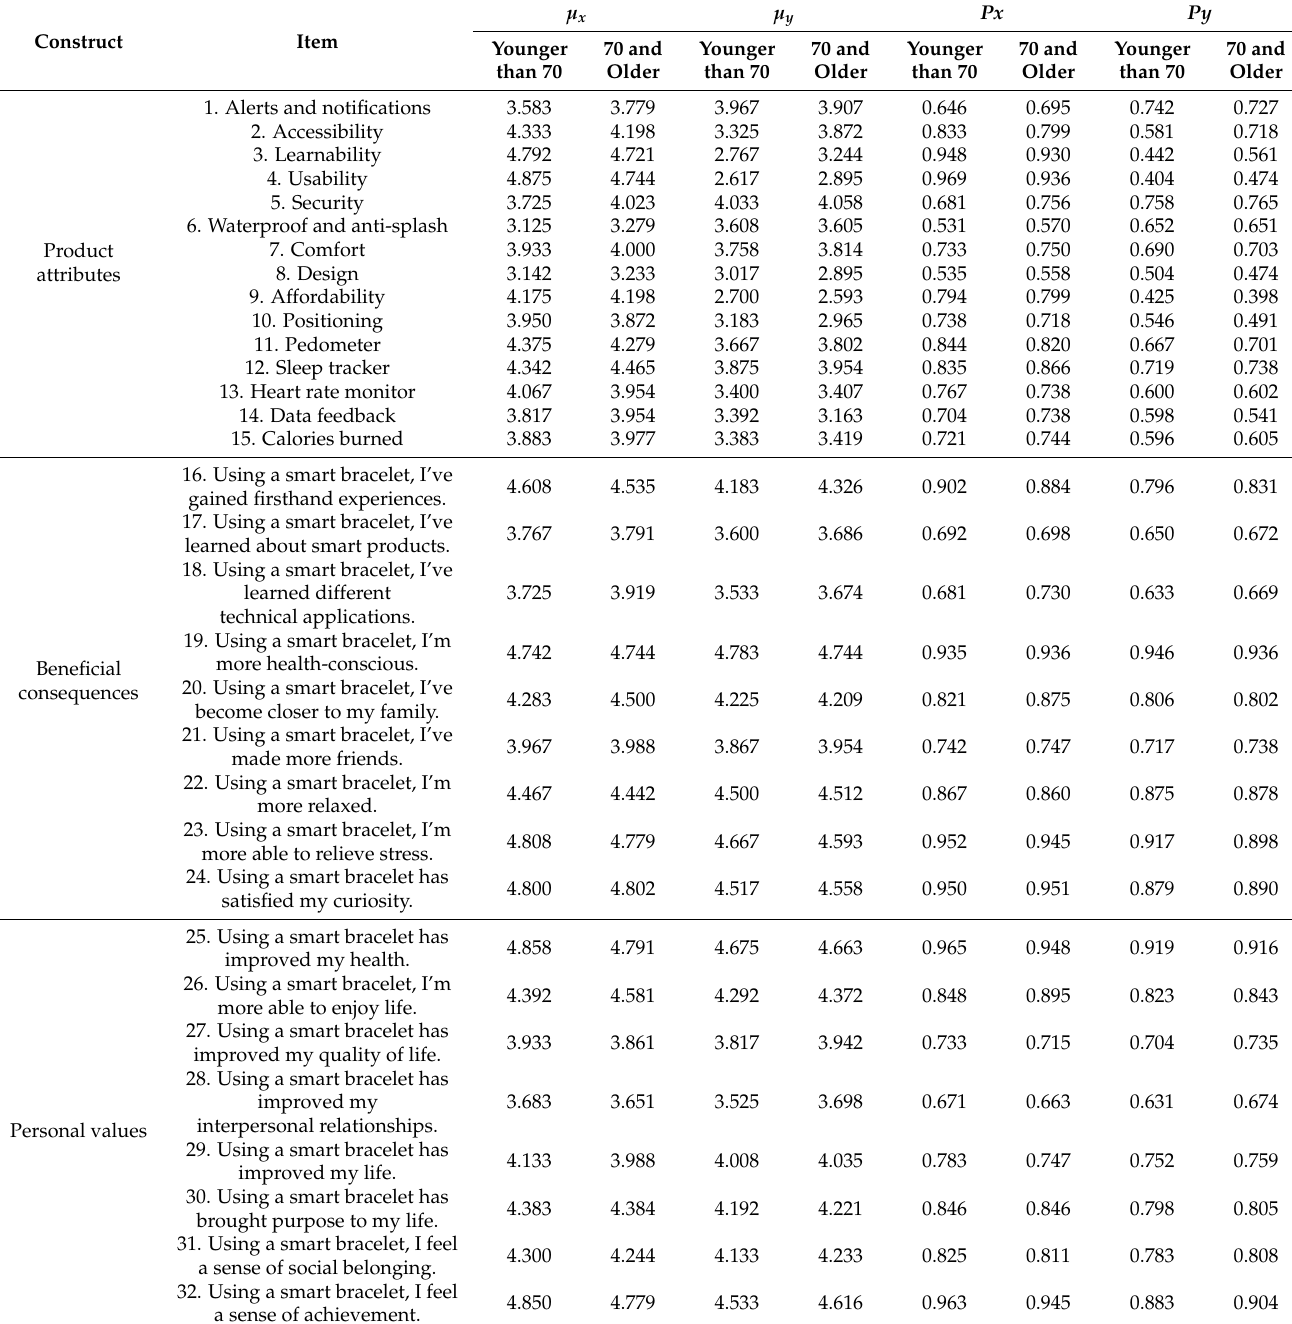
Table 7. Performance Values of the Importance–Satisfaction Variables Based on